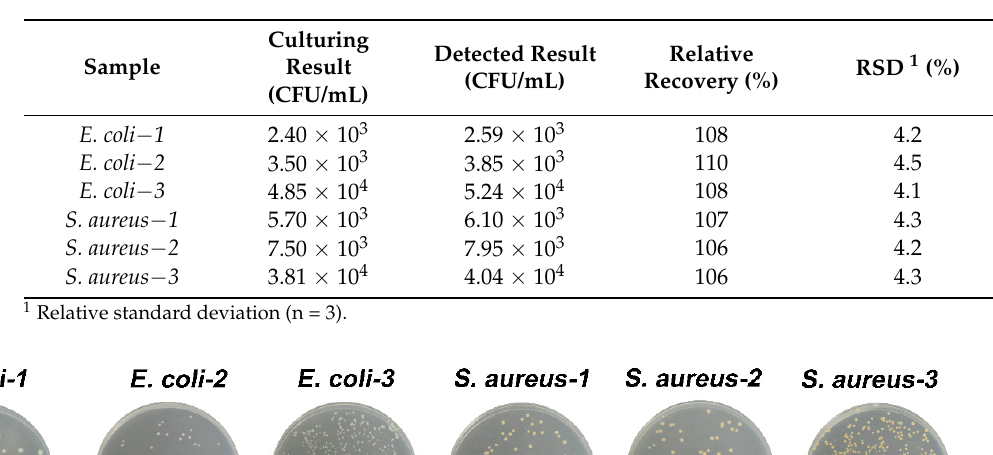
Table 1. Detection of the concentration of bacteria in tap water based on the culturing method and the constructed method in this work.